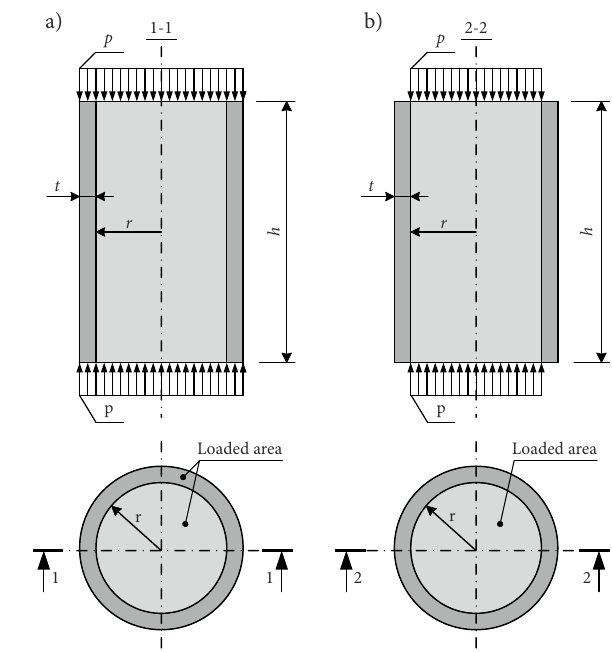
Figure 2. Loading of strengthened specimens: (a) – loading through the whole surface; (b) – loading through the internal concrete core. Here designations p – external load pressure; Figure 1. Preparation of specimens: (a) – surface after t – thickness of external jacket; r – radius of internal concrete treatment with high pressure water jet; cylinder; h – height of the specimen (b) – specimens in the moulds Table 4. Material mechanical parameters obtained from compression test Specimen (quantity of